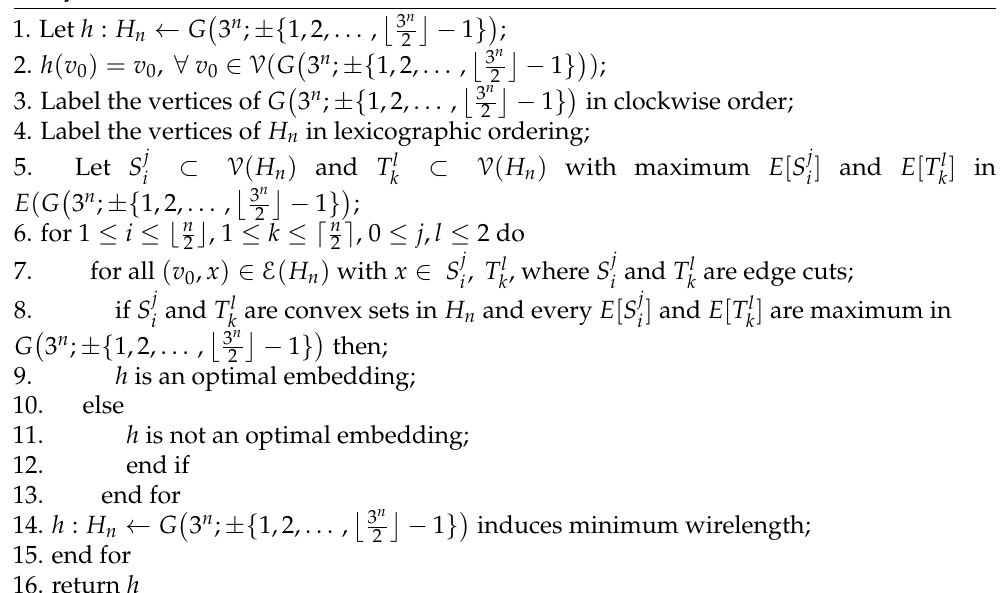
(cid:4) 3 n (cid:5) − (cid:1) 1 } into 2